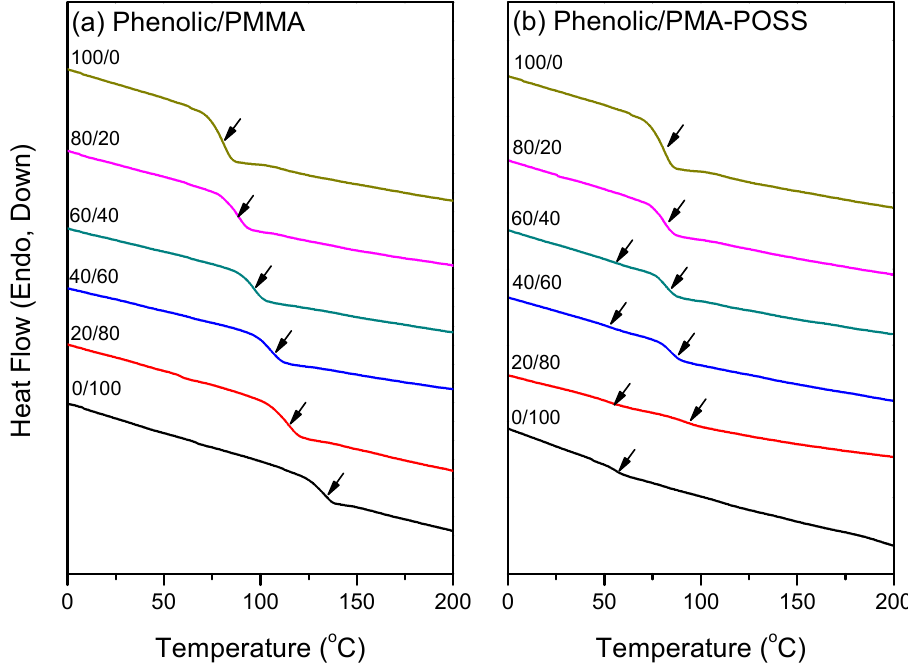
Figure 3. DSC thermograms of ( a ) PMMA and ( b ) PMA-POSS blends containing various phenolic compositions (weight